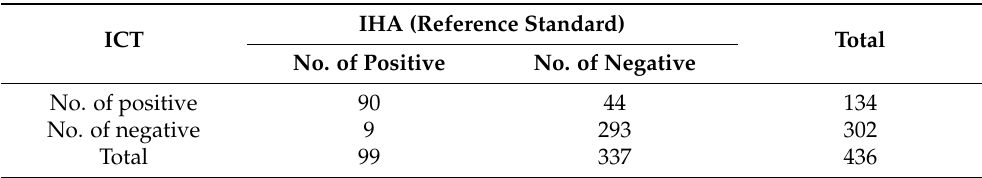
Table 2. Comparing the number of positive and negative samples detected by the ICT and IHA methods.